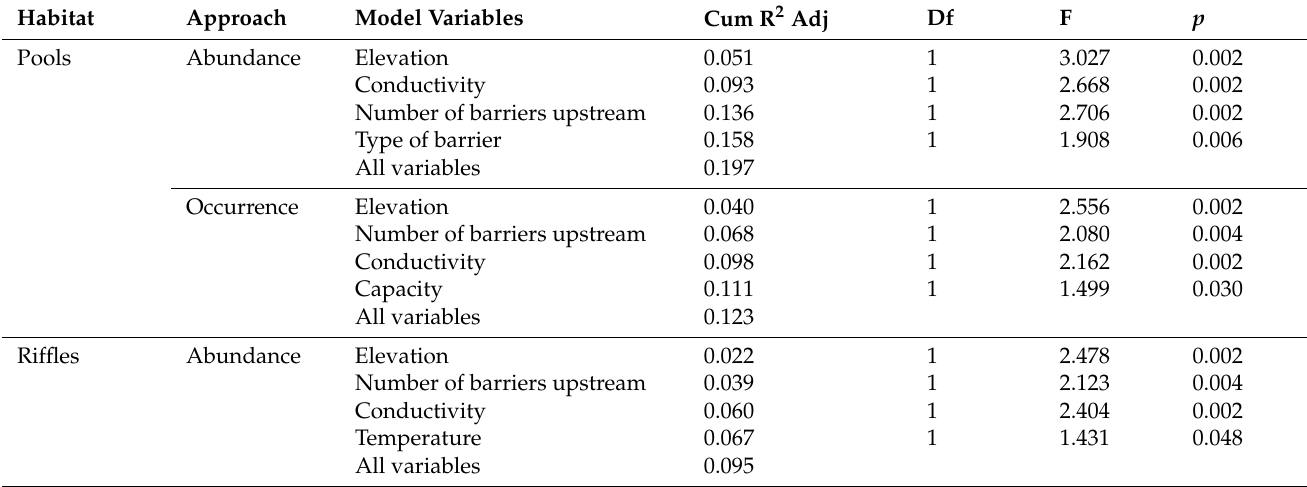
Table 4. Fragmentation and environmental variables at local level (site) that explain variation (model) in the native fish assemblage in eight river basins